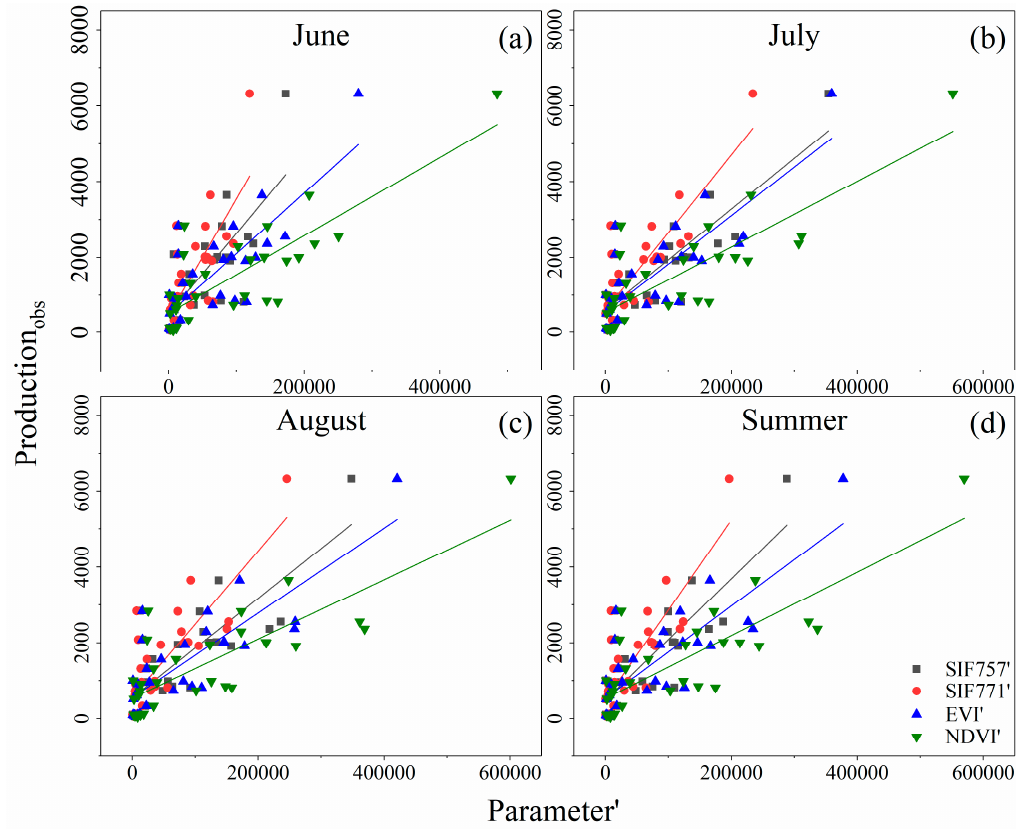
Figure 2. The correlations between the SIF757’, SIF771’, EVI’, NDVI’, and the government’s autumn crop production statistics (ten kilotons) in China during June to August 2015 at the monthly and seasonal scales. The parameter’ represent SIF757’ (W m − 2 sr − 1 µ m − 1 ), SIF771’ (W m − 2 sr − 1 µ m − 1 ), EVI’, and NDVI’, respectively. Table 1. The correlations between the SIF757’, SIF771’, EVI’, NDVI’, and the government’s autumn crop production statistics in China during June to August 2015 at monthly and seasonal scales.